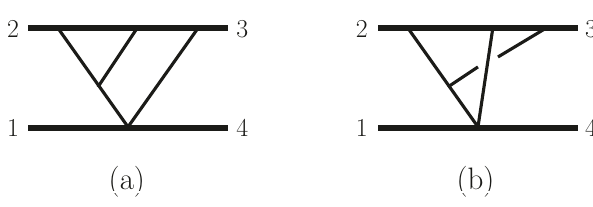
Figure 28 . Planar and nonplanar triangle integrals which appear in the cuts in (cid:12)gure 12(a). to take the standard straight line form. We do not include them explicitly here.